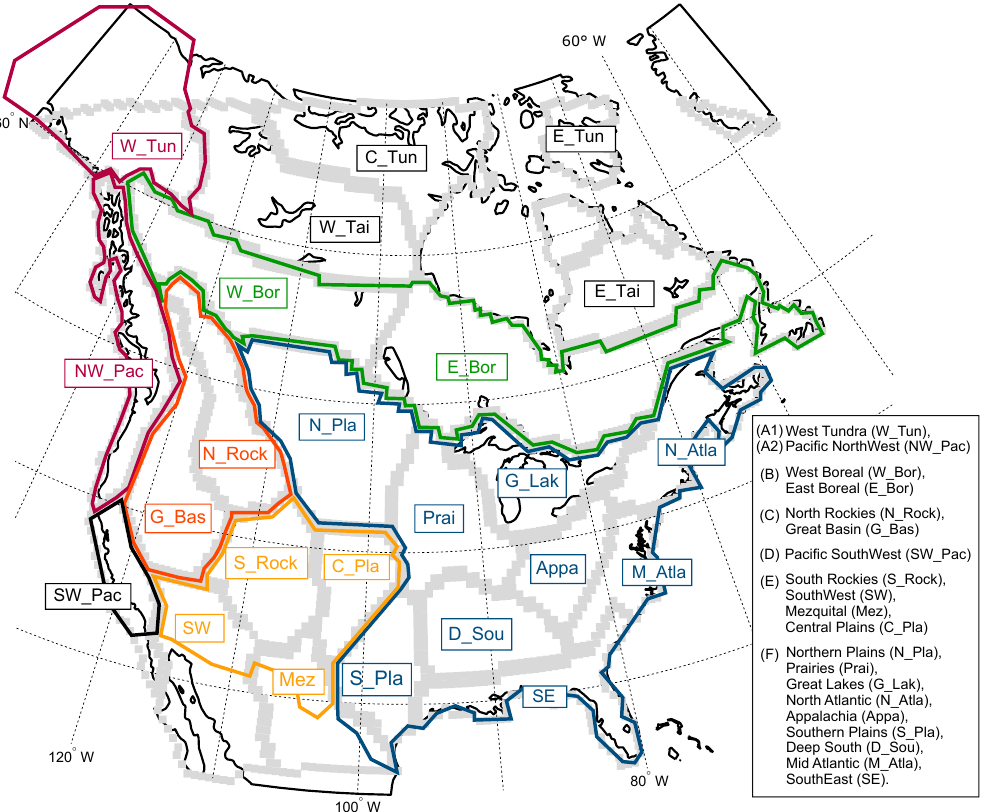
Figure 7. Climatic regions of Bukovsky (2012) (grey borders) and regions defined for this analysis (regions A1 to F in the legend; colored borders). Abbreviations for each region are in